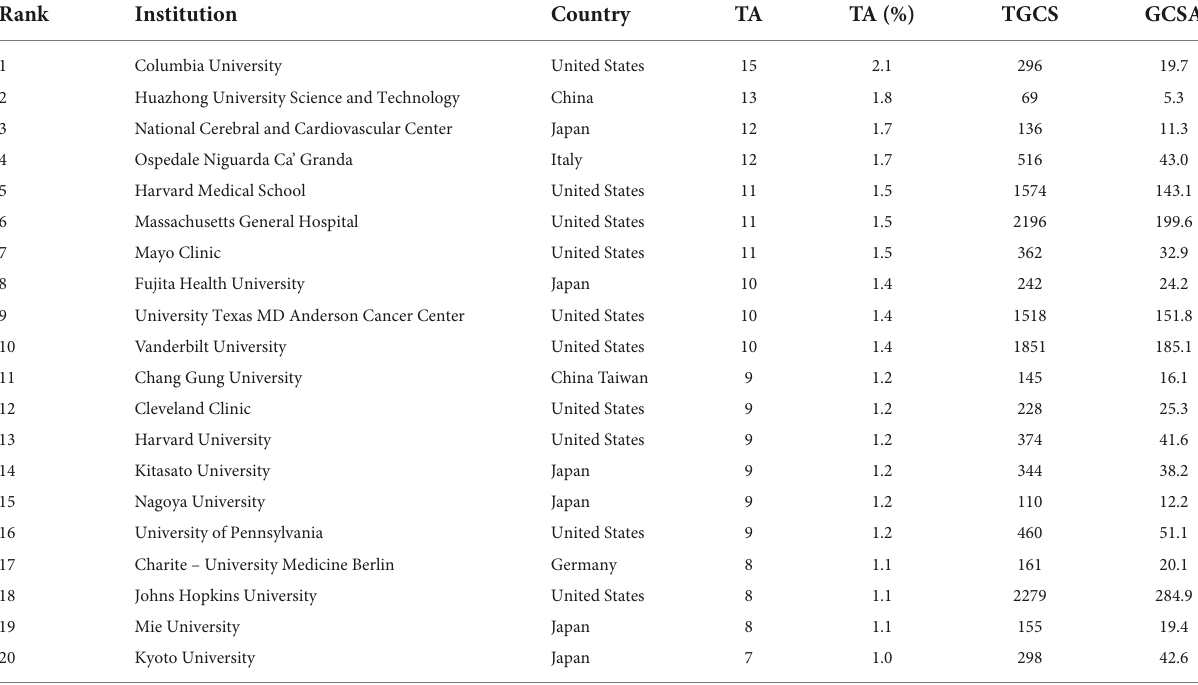
TABLE 2 Quantitative measurements of institutions publishing articles concerning “fulminant myocarditis” research.